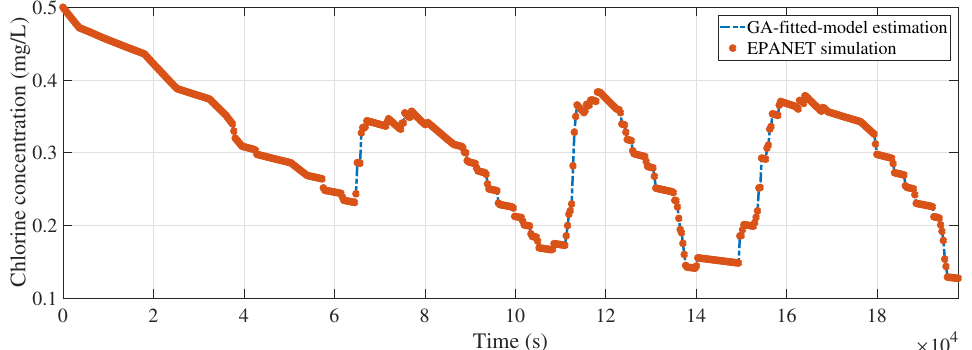
Figure 7. Calibrated model fitting for node 10 (rmse = 7.2047 × 10 − 5 mg/L).